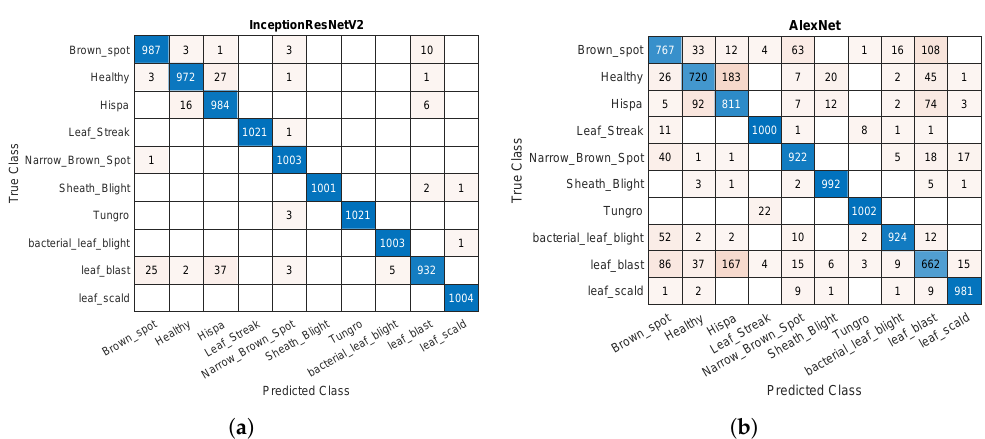
Figure 7. Confusion matrices for the finest and the poor performing models using 5-Fold cross validation ( a ) InceptionResNetV2; ( b ) AlexNet.